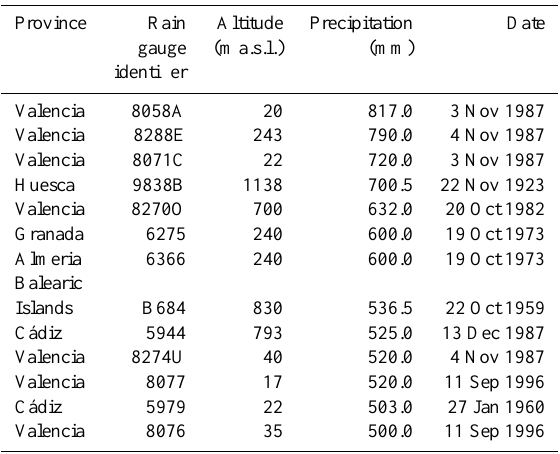
Table 2. Spanish daily rainfall records exceeding 500mm in the database (until 2008).